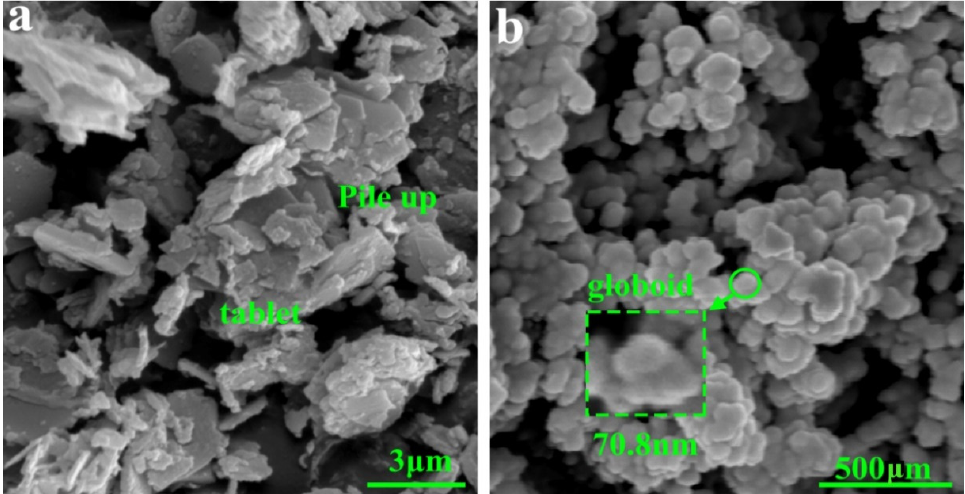
Figure 2. ( a ) Electron micrograph of silicon dioxide, ( b ) Electron micrograph of zinc oxide.